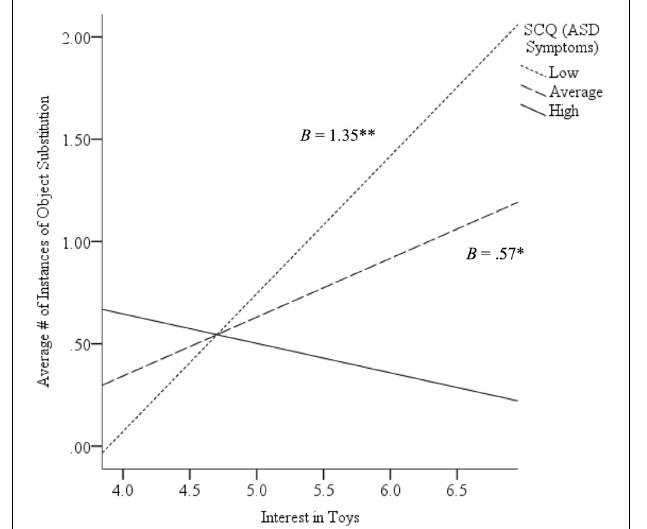
FIGURE 2 | Relation between level of interest in toys and observed instances of object substitution (OS) based on high, average, or low scores on the Social Communication Questionnaire [SCQ; i.e., autism spectrum disorder (ASD) symptoms]. While there was a positive relation between interest and quantity of OS for those with a history of few or average ASD symptoms, this relation was not found for those with a history of more ASD symptoms. ∗ p < 0.05, ∗∗ p < 0.01. Low = 1 SD below sample mean. Average = sample mean. High = 1 SD above sample mean.